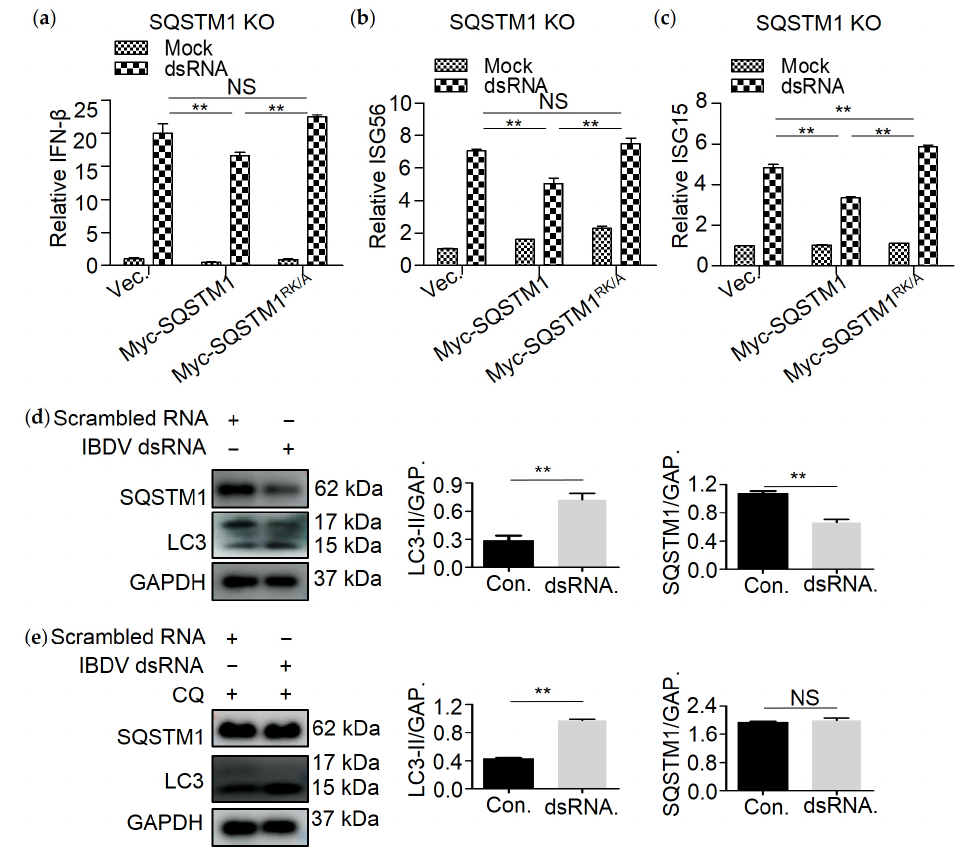
Figure 6. SQSTM1 is critical for dsRNA-induced production of interferon β . ( a ) dsRNA degradation by SQSTM1 inhibited the generation of IFN- β , while its variant SQSTM1 RK/A recovered it. SQSTM1 KO cell lines were cotransfected with Myc-SQSTM1 or its variant Myc-SQSTM1 RK/A and dsRNA. Cells were collected after 8 h, and RNA was extracted from the cells, and qRT-PCR was conducted to measure the IFN- β and ISG56 ( b ), ISG15 ( c ), and β -Actin mRNA from SQSTM1 KO cell lines. 293T cells were transfected with IBDV dsRNA and treated either with ( e ) or without lysosomal inhibitor CQ ( d ). Scramble RNA was a negative control. Western blot analysis using SQSTM1 and LC3 was performed. Data were represented as mean ± SD of three independent experiments. NS, not significant ( p > 0.05); ** p < 0.01.